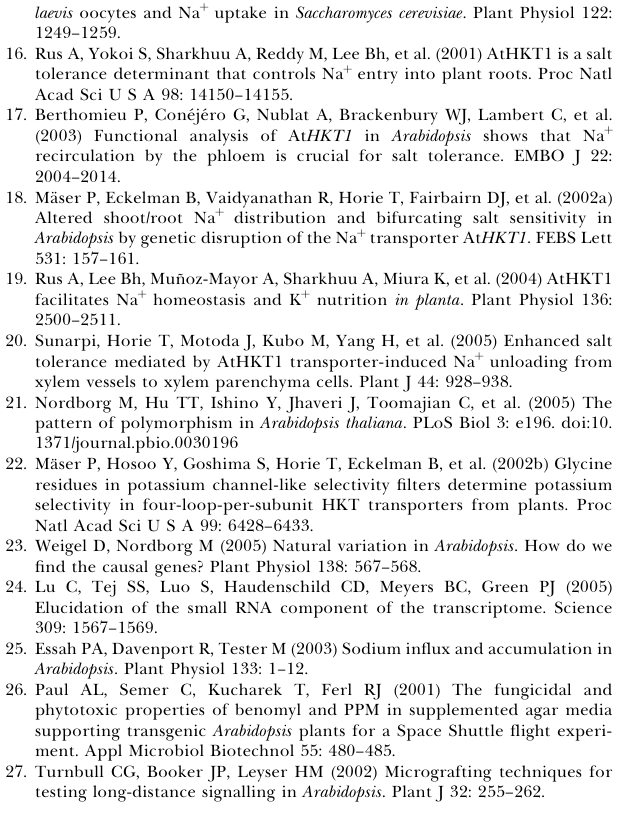
Figure S1. Higher Na þ Accumulation in Ts-1 and Tsu-1 Under Unstressed and NaCl Stress Conditions Na þ contents were analyzed in leaves at four different stages of development (as described in Materials and Methods) across the shoot of 44-d-old Col-0 (circles), Ts-1 (triangles), Tsu-1 (squares), and hkt1–1 (diamonds) plants grown in soil under short-day conditions and treated for 17 d with (A) no NaCl addition, (B) 50 mM, or (C) 100 mM NaCl. Presented data are the mean 6 SE. Found at doi:10.1371/journal.pgen.0020210.sg001 (314 KB PPT). Figure S2. Alignment of At HKT1 cDNA and promoter sequences from Col-0, Ts-1, and Tsu-1(A) At HKT1 cDNA sequences.(B) At HKT1 promoter sequences. Table S1. List of Primer Pairs Used to Sequence the At HKT1